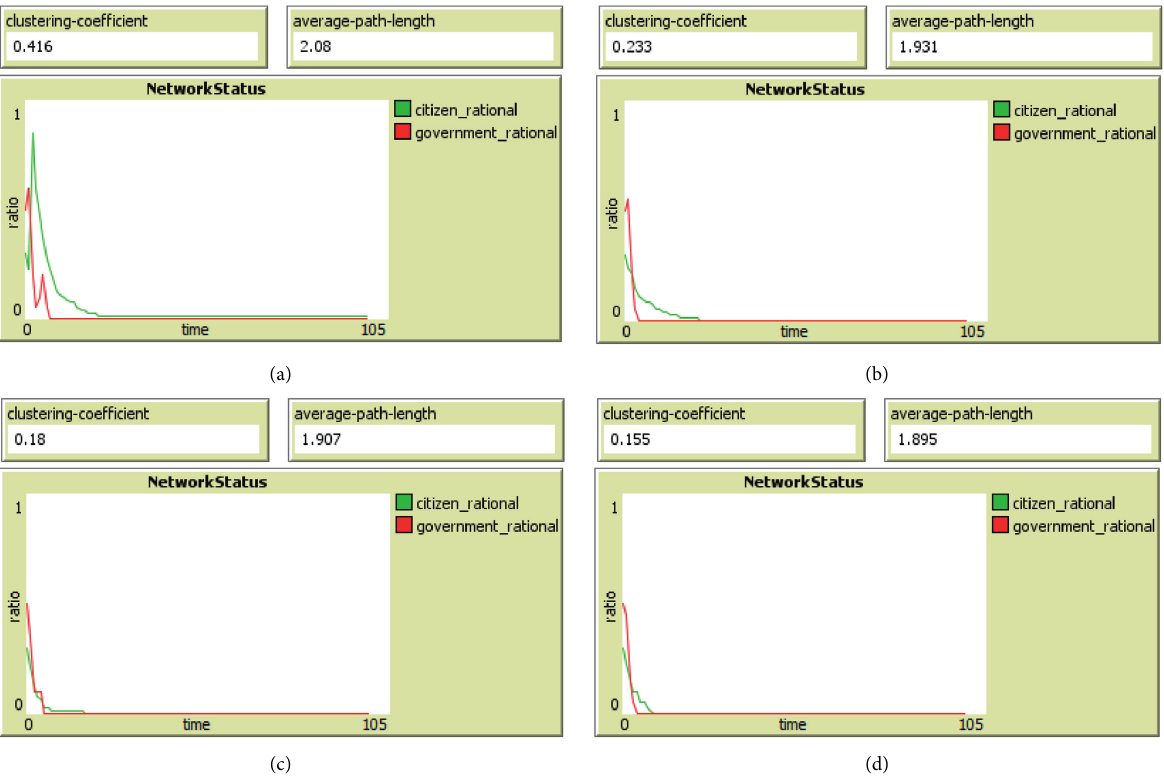
Figure 5: The evolutionary result when the reconnection probability p takes different values in scenario two (the initial state is located in region I and II): (a) the evolutionary result when p � 0.2; (b) the evolutionary result when p � 0.4; (c) the evolutionary result when p � 0.6; (d) the evolutionary result when p �